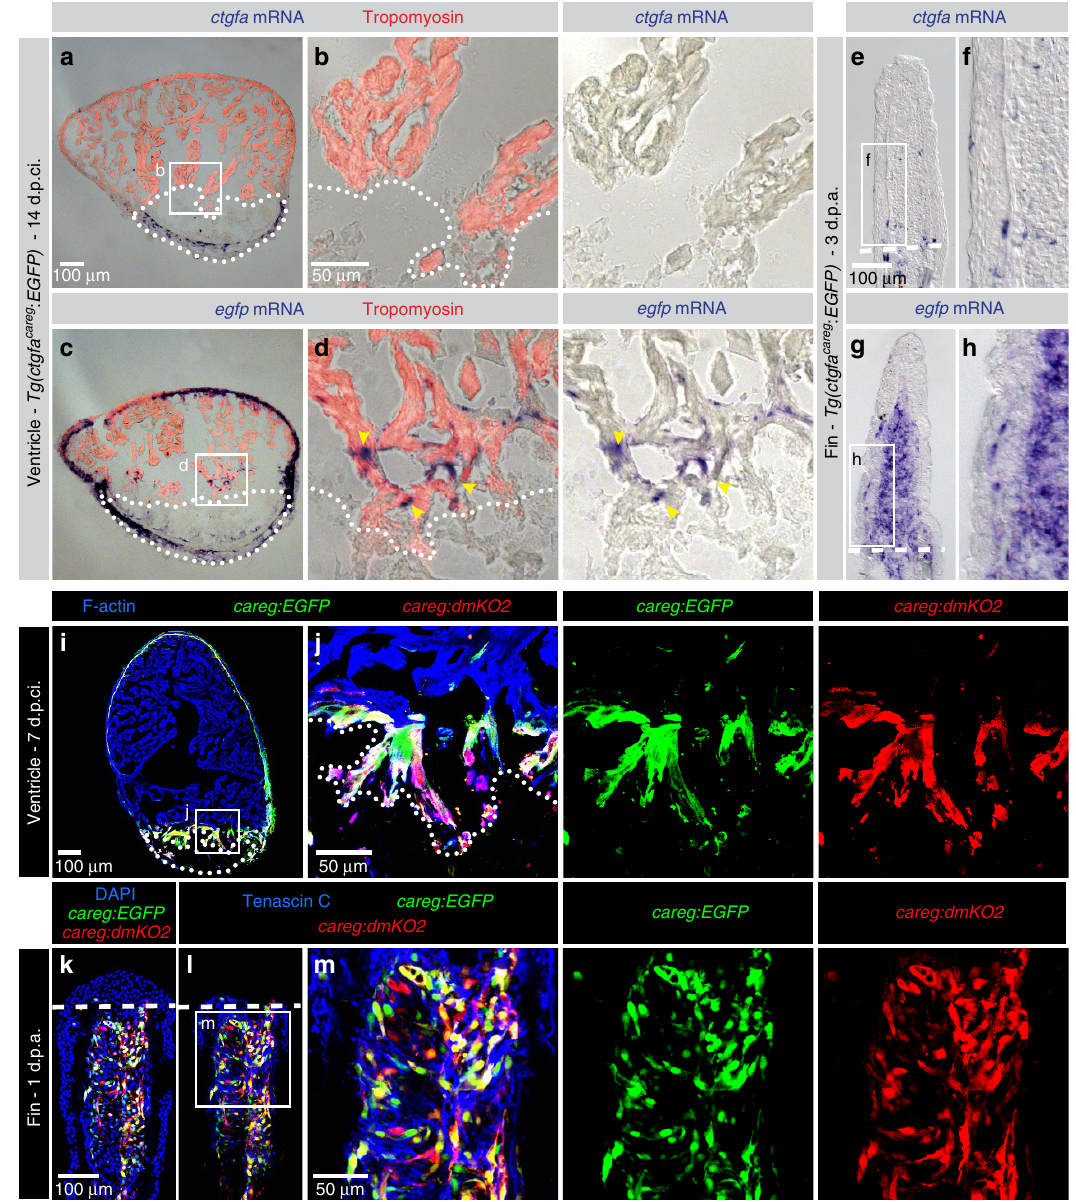
Figure 2 | ctgfa careg :EGFP does not reproduce endogenous ctgfa expression in peri-injury tissues. ( a – h ) In situ hybridization using ctgfa and enhanced green fluorescent protein (egfp) probes on sections of hearts at 14 d.p.ci. and fins at 3 d.p.a. of ctgfa careg :EGFP transgenic fish shows distinct expression patterns. ( a , b ) ctgfa mRNA is not detected in the myocardium, but in a subset of non-myocytes in the post-infarcted tissue. ( c , d ) egfp mRNA is expressed in the outer wall of the myocardium and at the peri-injury zone (yellow arrowheads). ( e , f ) ctgfa mRNA is present in a few bone-associated cells of the fin, while ( g , h ) egfp mRNA is detected in the blastema. N ¼ 6. ( i – m ) careg:EGFP and careg:dmKO2 double transgenic fish display an overlapping expression pattern in the regenerating heart at 7 d.p.ci. and the fin at 1 d.p.a. N ¼